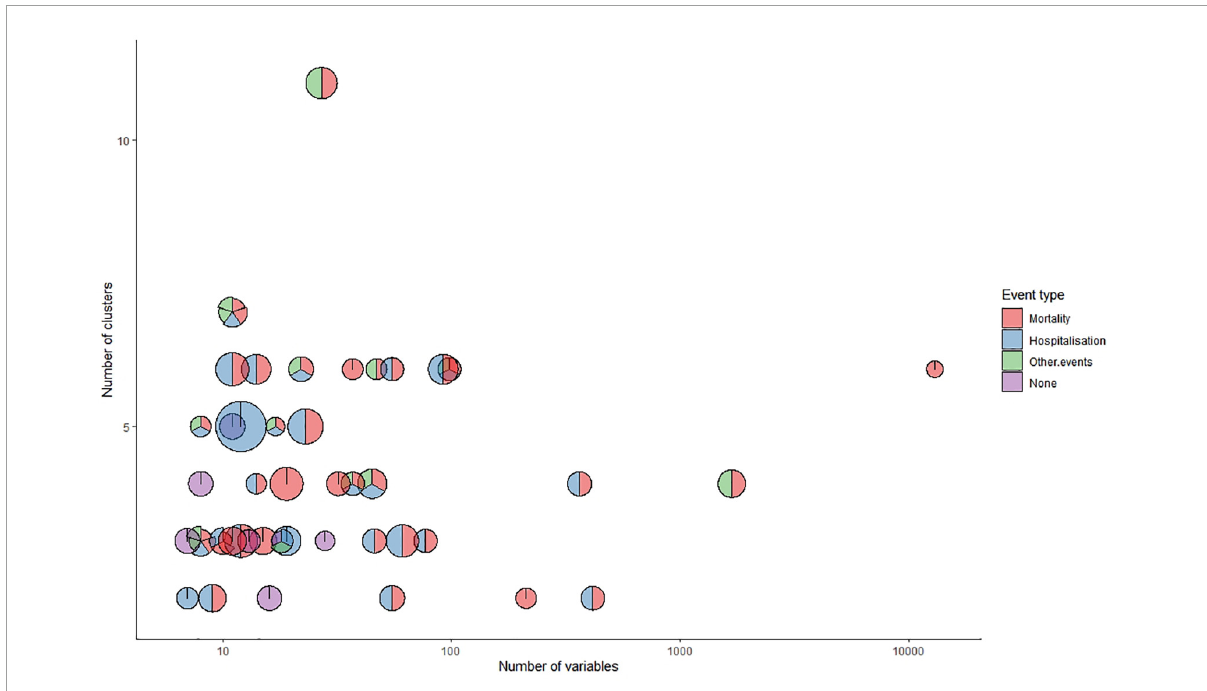
FIGURE6 Features of the clusters identified in the included